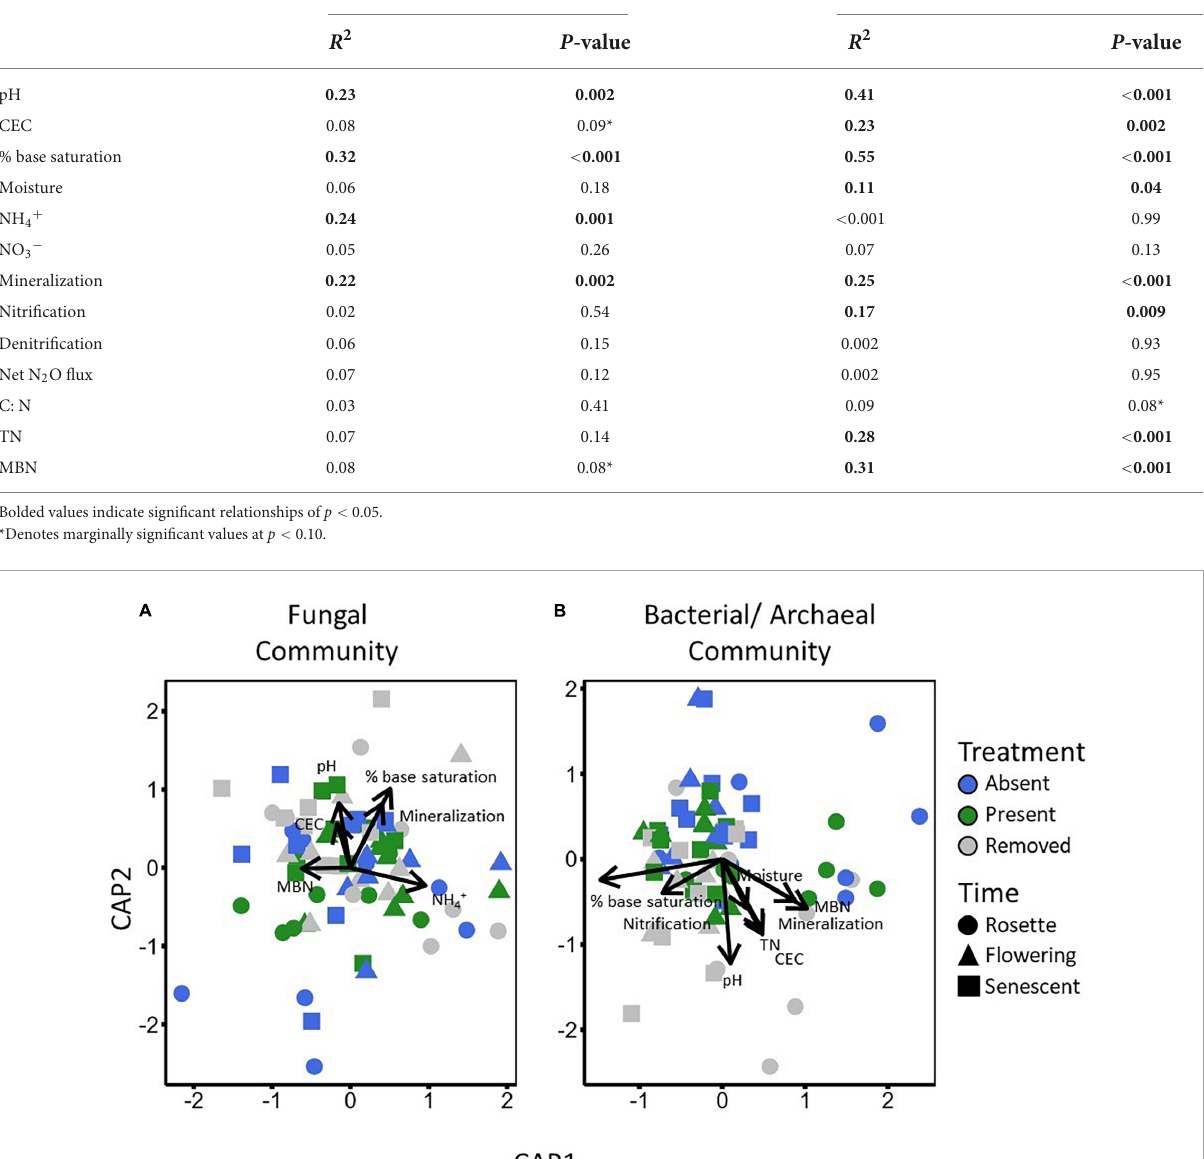
TABLE 3 Redundance analysis for correlation of environmental and N cycling variables with constrained PCoA ordiantions for fungal and bacterial/archaeal communities. Variable